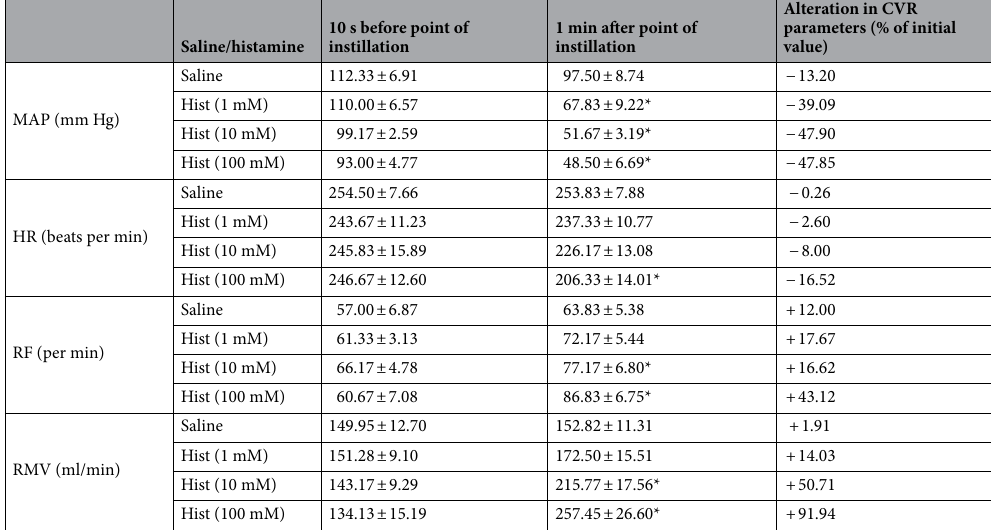
Table 1. Cardiorespiratory (CVR) changes before and after instillation of saline/histamine. MAP mean arterial pressure, HR heart rate, RF respiratory frequency, RMV respiratory minute volume. In the last column, +/− indicates increase/decrease respectively. An asterisk (*) indicates significant alteration in CVR parameters as compared with the saline control group [ P < 0.05, two sided Dunnett’s test] and with the initial value [ P < 0.05, Paired